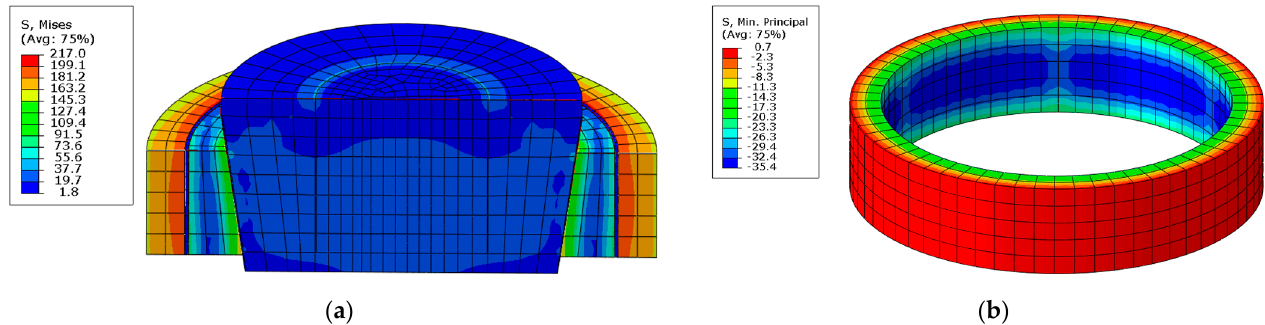
Figure 15. Results of the FEM analysis of the interaction of the split ring with the sample; reduced stresses ( a ), radial stresses: visible contact areas ( b ).